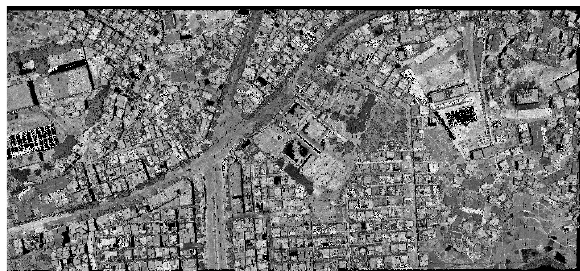
Figure 2. Intensity image of the second dataset